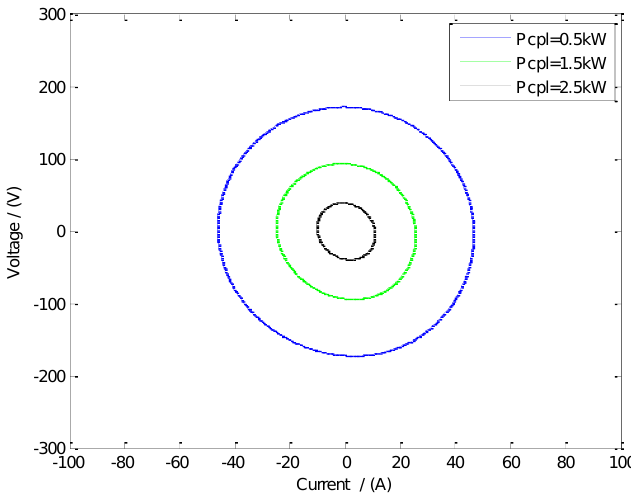
Figure 6. Changes in system stability region.